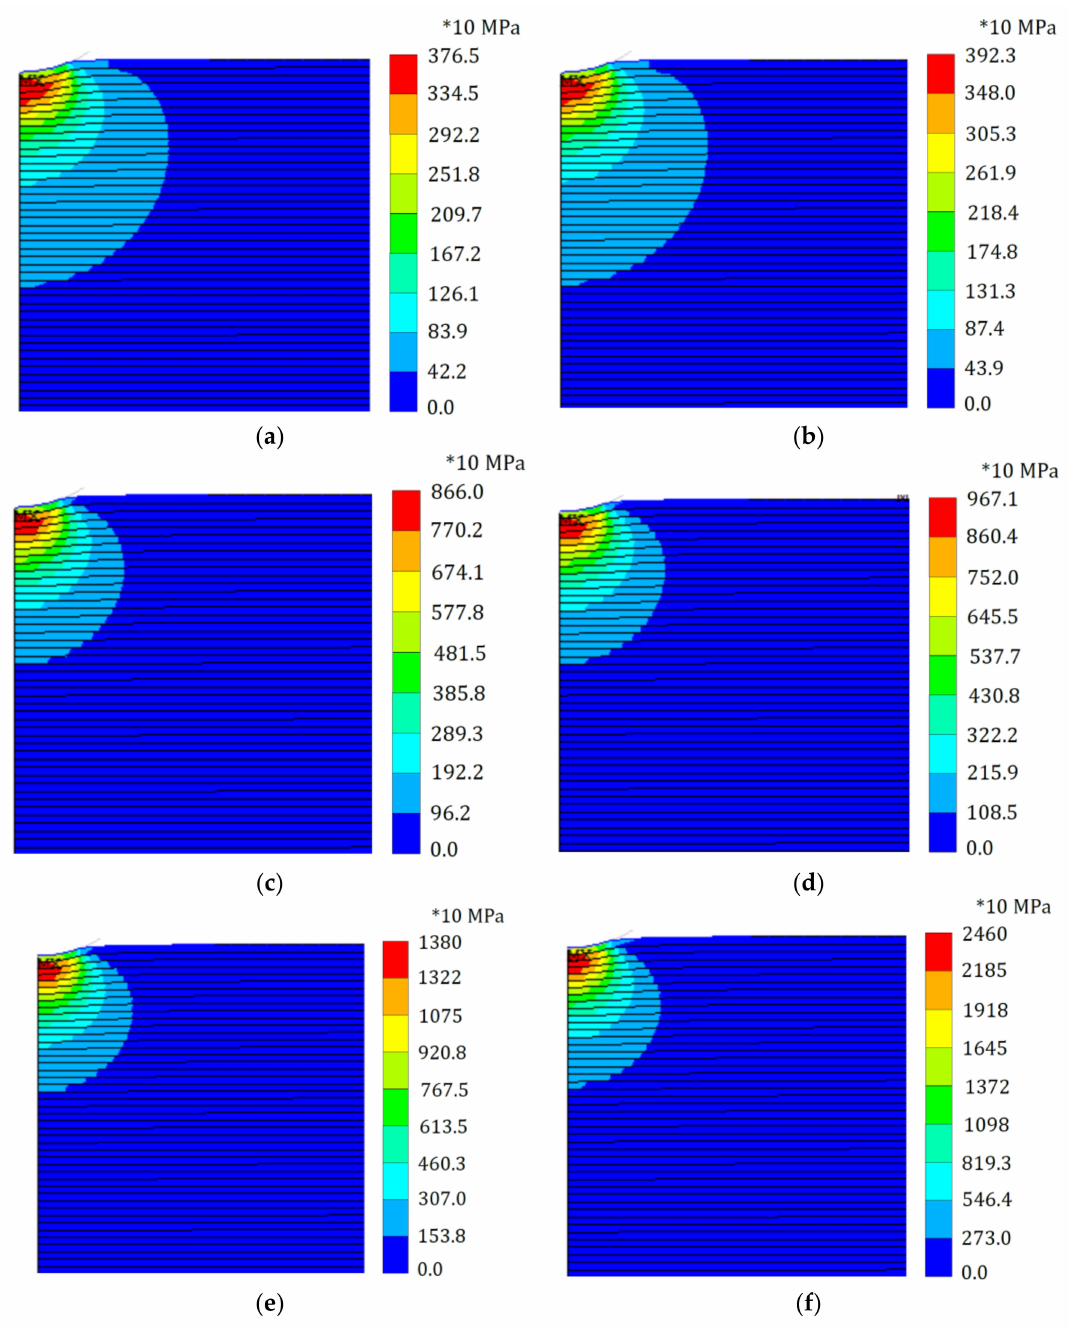
Figure 9. Distributions of the von Mises equivalent stress (at full load) within the elastoplastic Ti/TiB specimen at different gradient indices; ( a ) S-FGM with K = 0.5, and ( b ) P-FGM with K = 0.5, ( c ) S-FGM with K = 2, ( d ) P-FGM with K = 2, ( e ) S-FGM with K = 4 and ( f ) P-FGM with K =